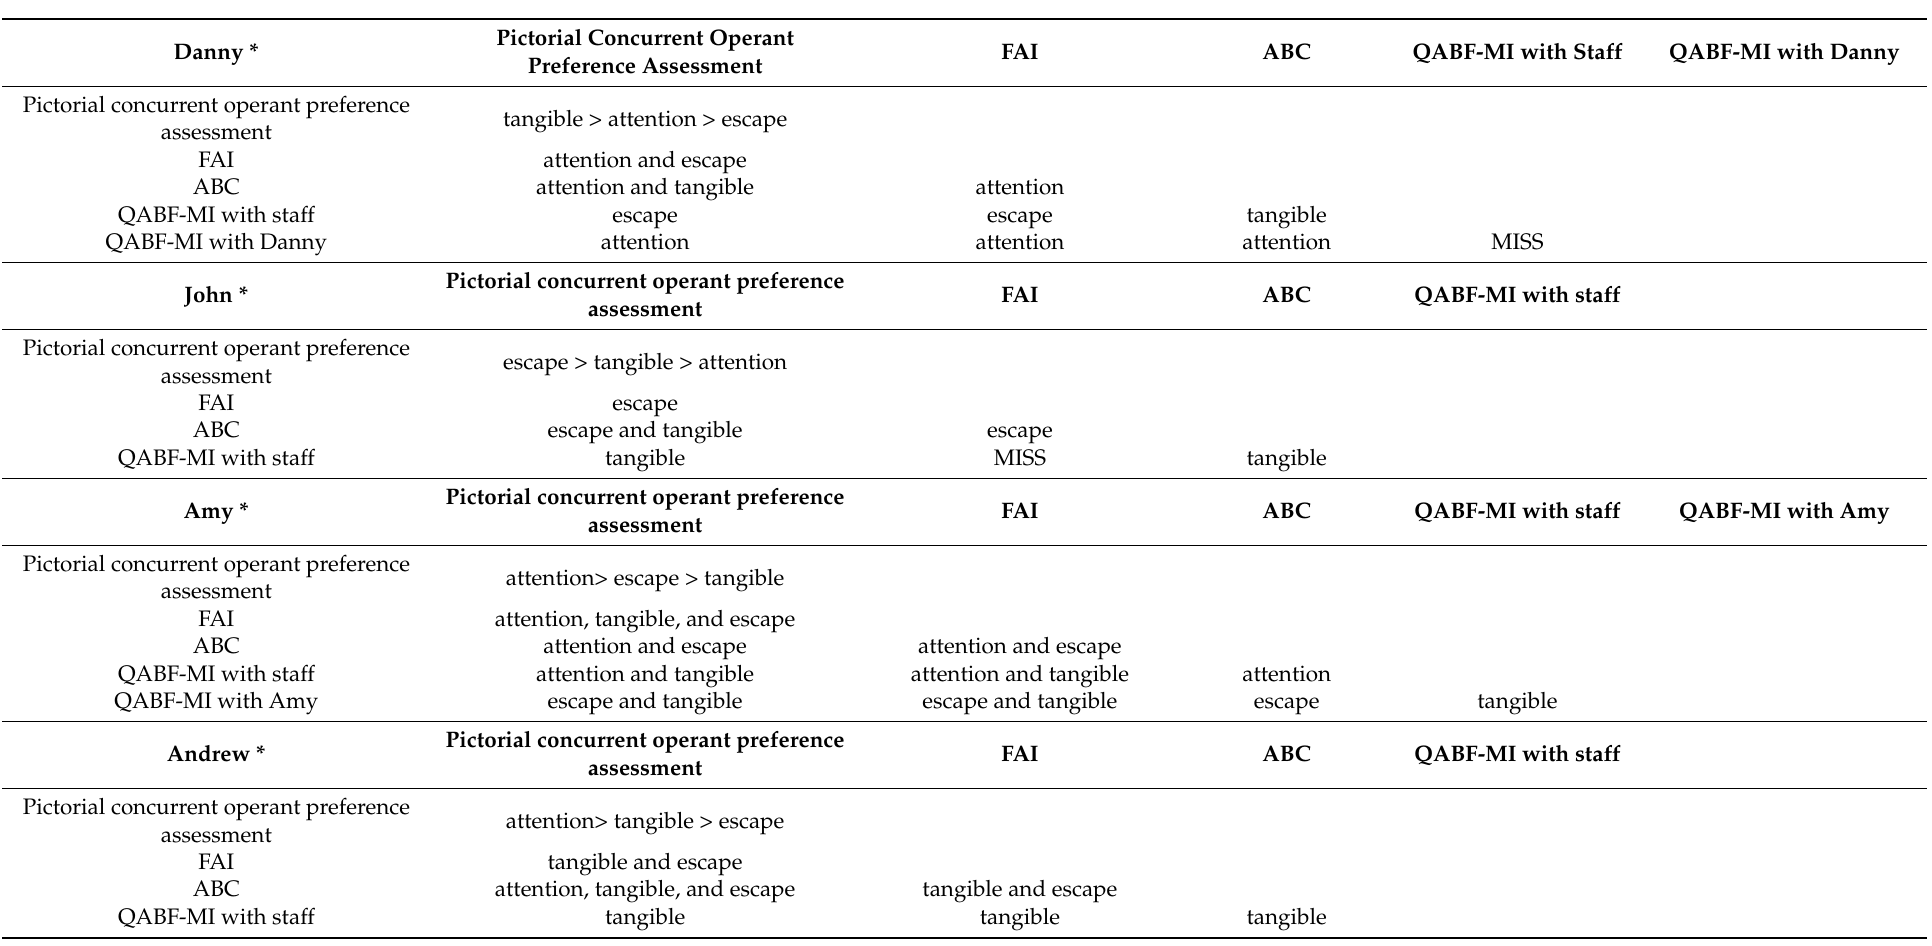
Table 3. Concordance among the pictorial concurrent operant preference assessment, the indirect FBA and the direct FBA in behavioral function. Danny * ABC QABF-MI with